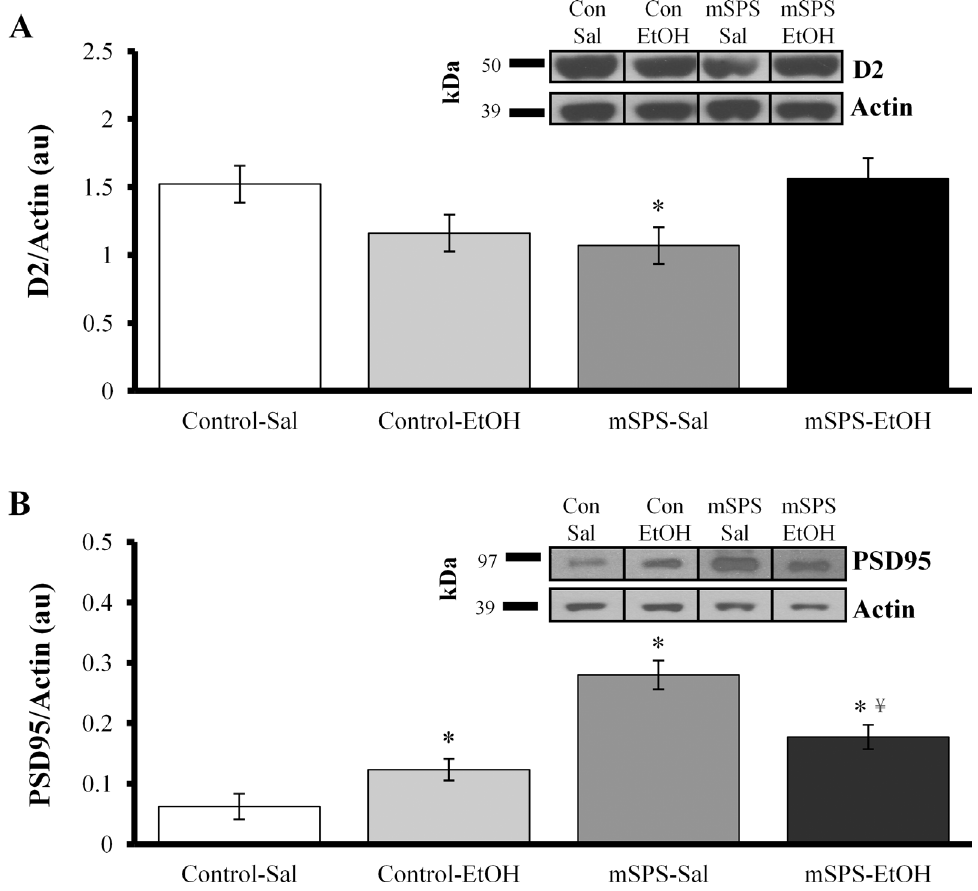
Fig 6. Interactions between mSPS and EtOH on D2-receptor and PSD95 protein levels. (A) Striatal D2 receptors were significantly decreased in mSPS-Sal mice compared to both Control-Saline and mSPS-EtOH mice ( * p < 0.05). Representative samples inserted in upper right corner (kDa, kilodaltons). (B) PSD95 was significantly increased in Control-EtOH, mSPS-Sal, and mSPS-EtOH mice compared to Control-Sal mice ( * p < 0.05). PSD95 was also significantly decreased in mSPS-EtOH mice compared to mSPS-Sal mice ( ¥ p <